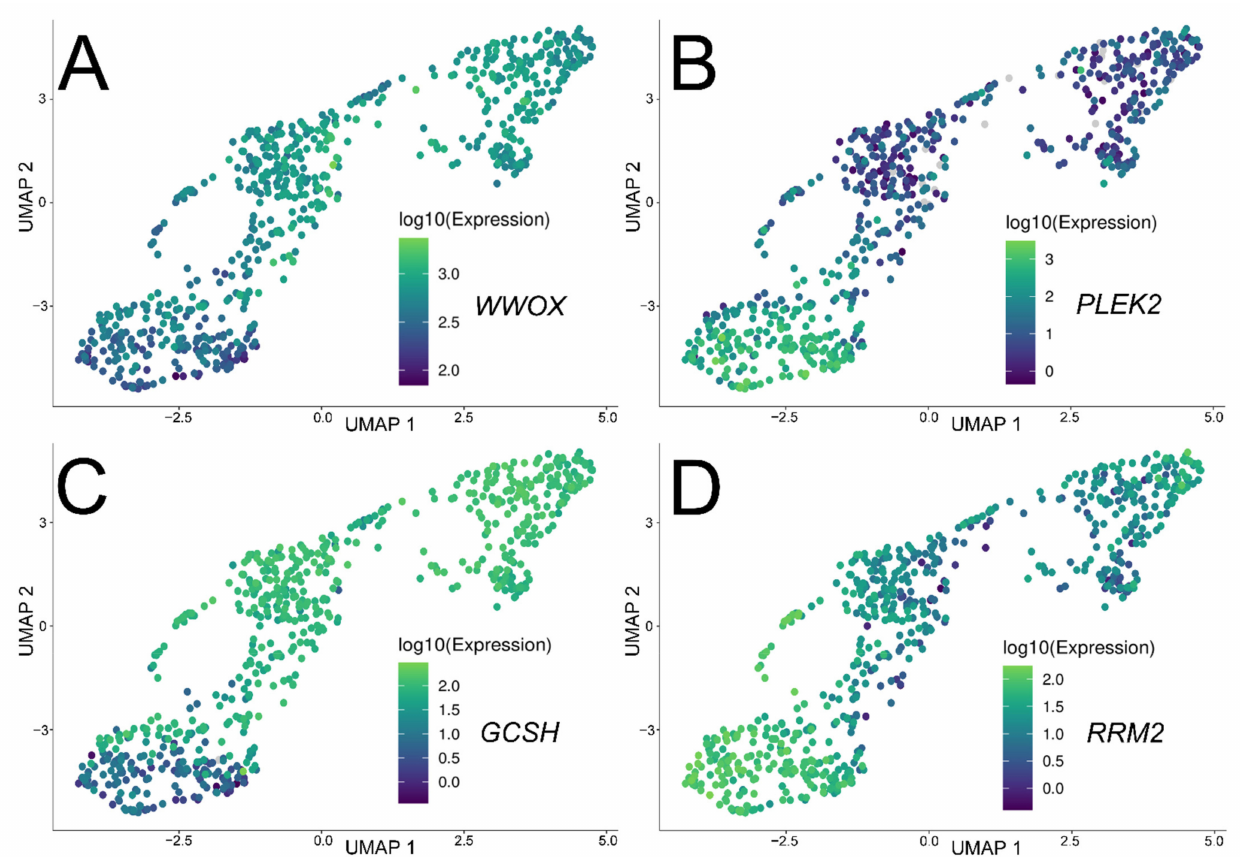
Figure 8. Spatial expression analysis of the 3 most relevant genes and WWOX. ( A ) WWOX . ( B ) PLEK2 . ( C ) GCSH . ( D ) RRM2 . The GBM cohort demonstrated markedly increased PLEK2 and lowered GCSH ex- pression compared to LGG, as well as a change in RRM2 expression similar to that of PLEK2 . According to Gene Expression Profiling Interactive Analysis (GEPIA2), the last two are positively correlated, i.e., R = 0.62, p < 0.0001 (Figure 9A); a negative correlation can be seen for PLEK2 and GCSH , i.e., R = − 0.32, p < 0.0001 (Figure 9B). Lastly, GCSH and RRM2 are not well correlated, indicated by a low correlation coefficient, i.e., R = − 0.23, p < 0.0001 (Figure 9C). Nevertheless, each of the three genes significantly correlated with WWOX ( GCSH positively, PLEK2 and RRM2 negatively) as shown in Table 3. Finally, the prognostic signatures of PLEK2 , RRM2 , and GCSH were adjusted using survival curves with “Estimation of Stromal and Immune cells in Malignant Tumors using Expression data” (ESTIMATE) score as covariate (Figure